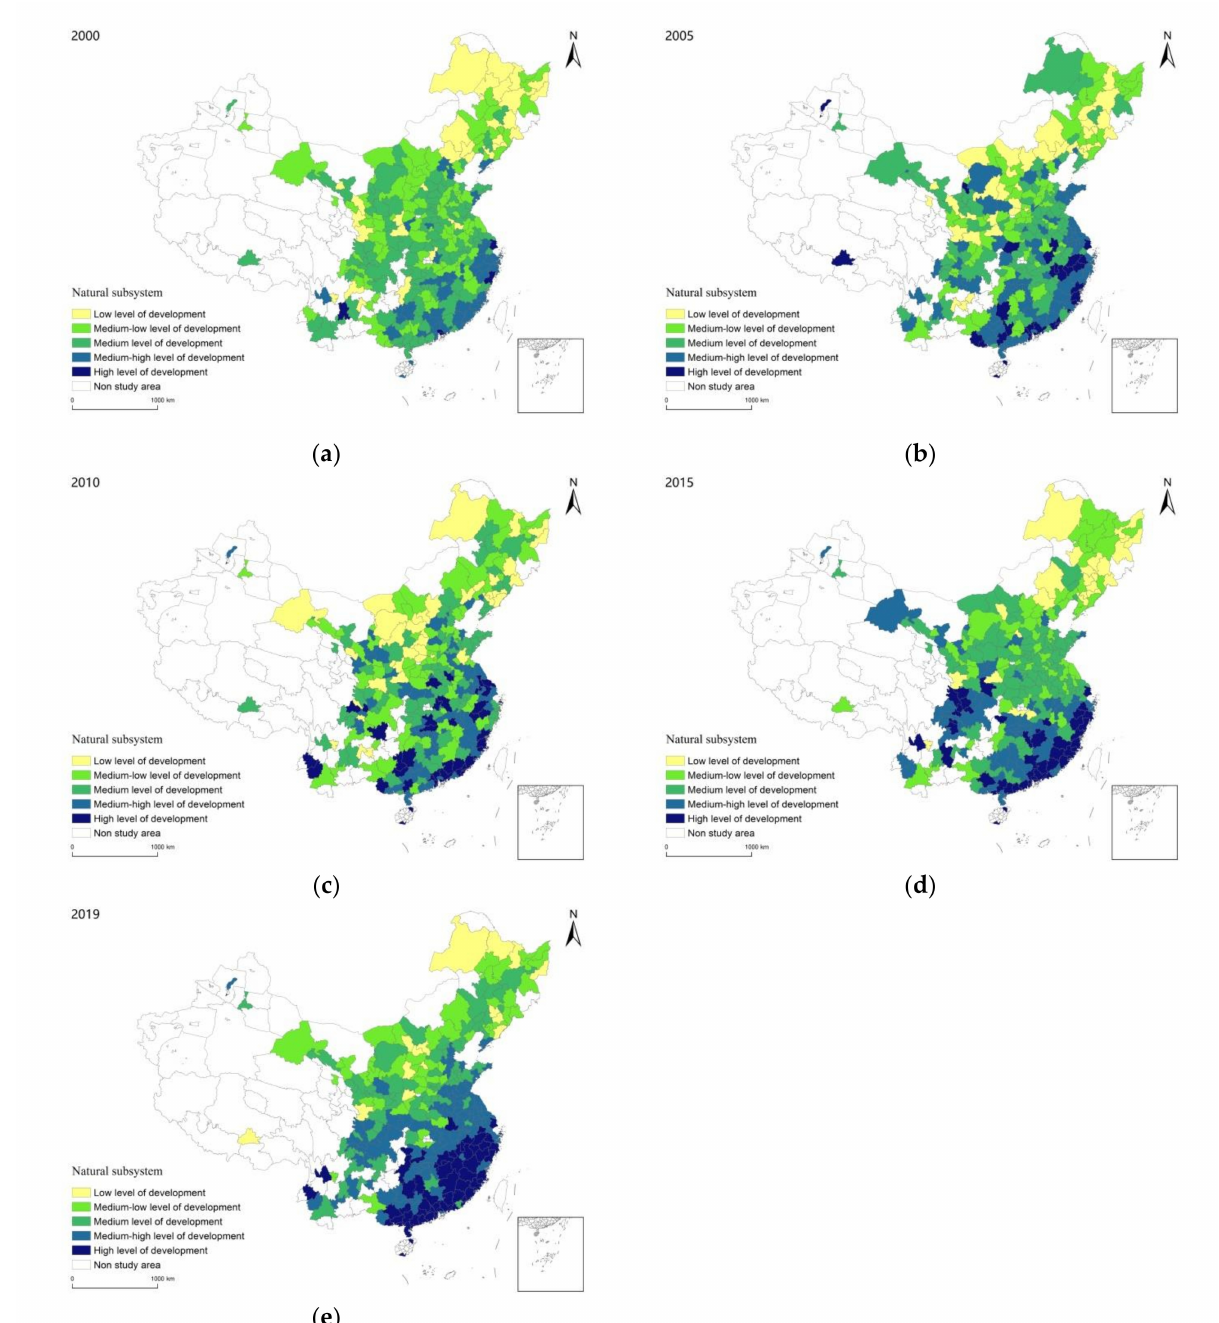
Figure 2. Spatial distribution map of the sustainable development level of the natural system of urban human settlements in China. ( a ) 2000; ( b ) 2005; ( c ) 2010; ( d ) 2015; and ( e ) 2019. The prefecture-level cities with a low level of development of the natural system of urban human settlements were found to be concentrated in the Heilongjiang Province in the Northeast, the Shanxi Province, and the Inner Mongolia Autonomous Region in North China; areas with low development levels continue to gather in the northeast. The low level of development of the natural system of urban human settlements in Jixi, Heihe, Hulunbuir, Baishan, Tianshui, and Baiyin is mainly due to serious soil erosion, low greening, fragile ecological environment, relatively backward development, and unawareness of environmental